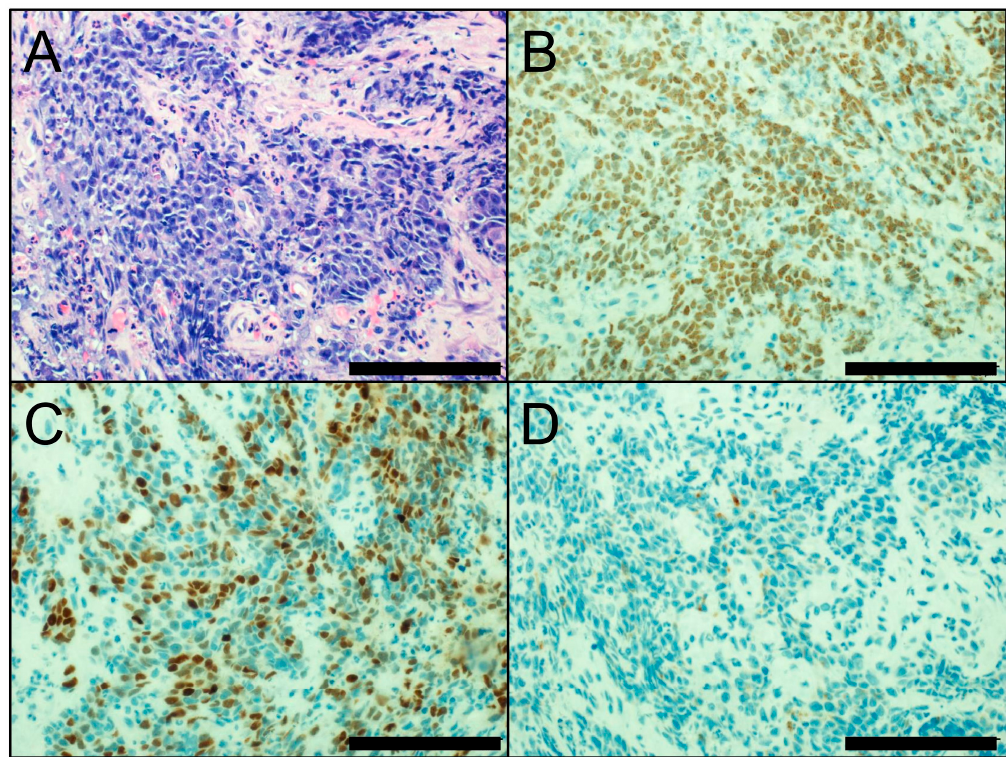
Figure 4. ( A ) Morphology of NUT carcinoma (hematoxylin and eosin staining). Immunohistochemistry of NUT carcinoma; ( B ) NUT staining (nuclear; positive); ( C ) p40 staining (nuclear; focally positive); and ( D ) SYP staining (cytoplasmic; very focally positive). Scale bar = 100 µm.